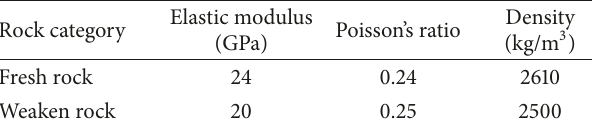
Table 2: The results of rock mass parameters